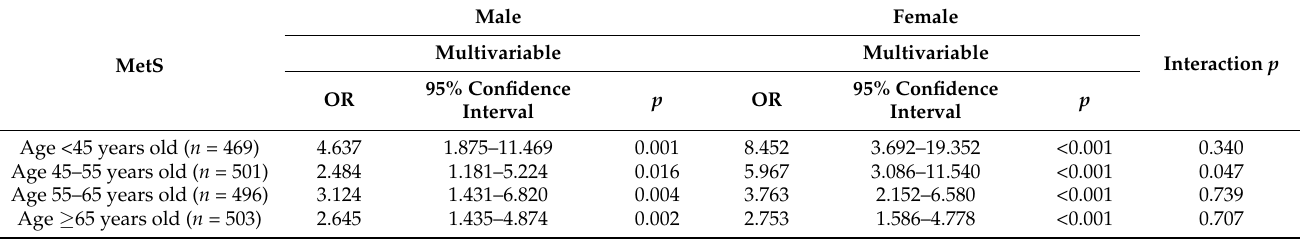
Table 3. Association of MetS with fatty liver using multivariable logistic regression analysis according to different age decades.